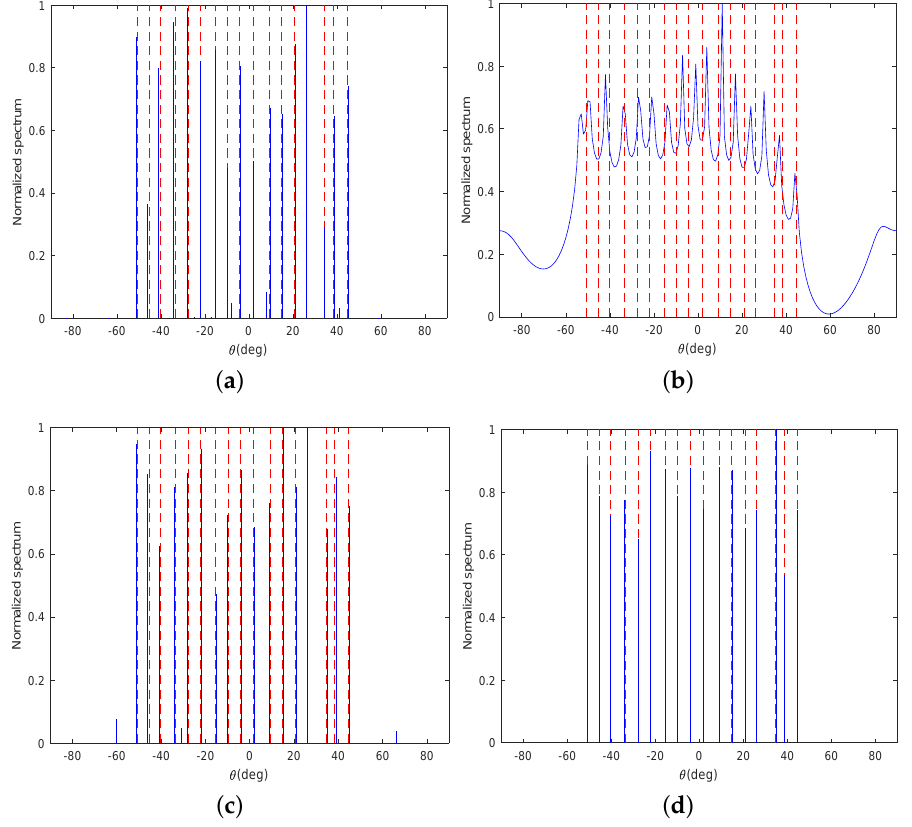
Figure 2. Spatial spectrums of the four algorithms with 17 sources. ( a ) Off-grid sparse Bayesian inference (OGSBI); ( b ) Low rank matrix denoising (LRD); ( c ) Least absolute shrinkage and selection operator (LASSO); ( d ) Proposed